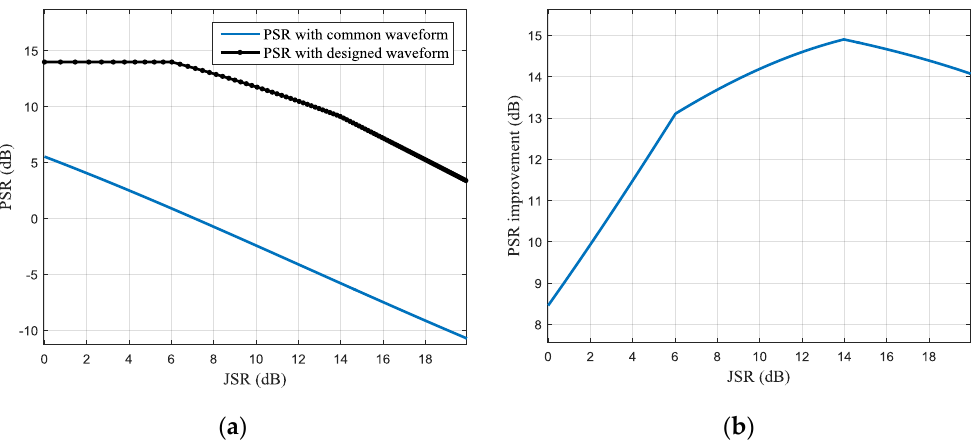
Figure 10. Peak-to-side-lobe ratio (PSR) of the pulse compression result under different jamming-to- signal ratio (JSR) ( a ) PSR of the pulse compression result with common and designed waveforms ( b ) PSR improvement with different JSR.